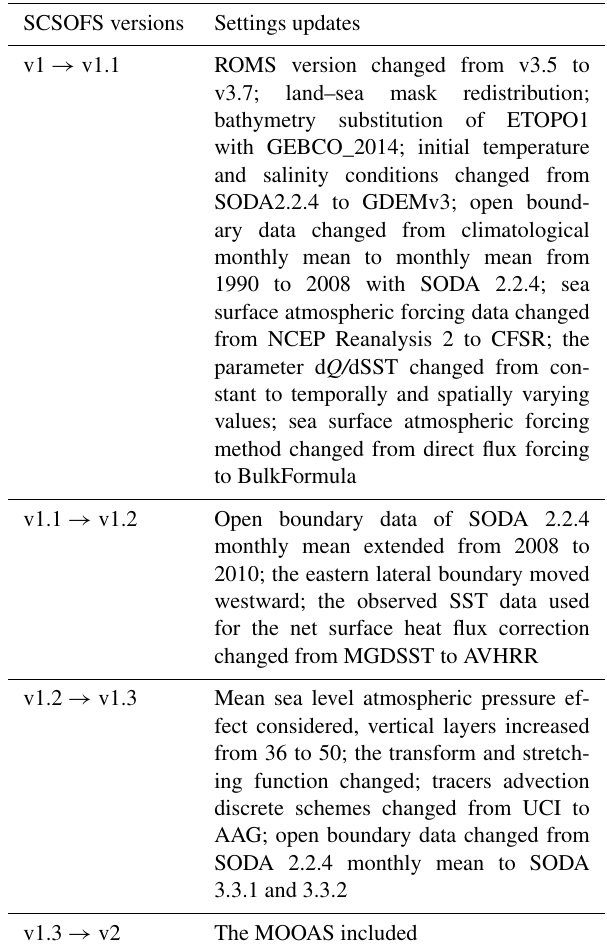
Table 2. The major upgrades with respect to the previous